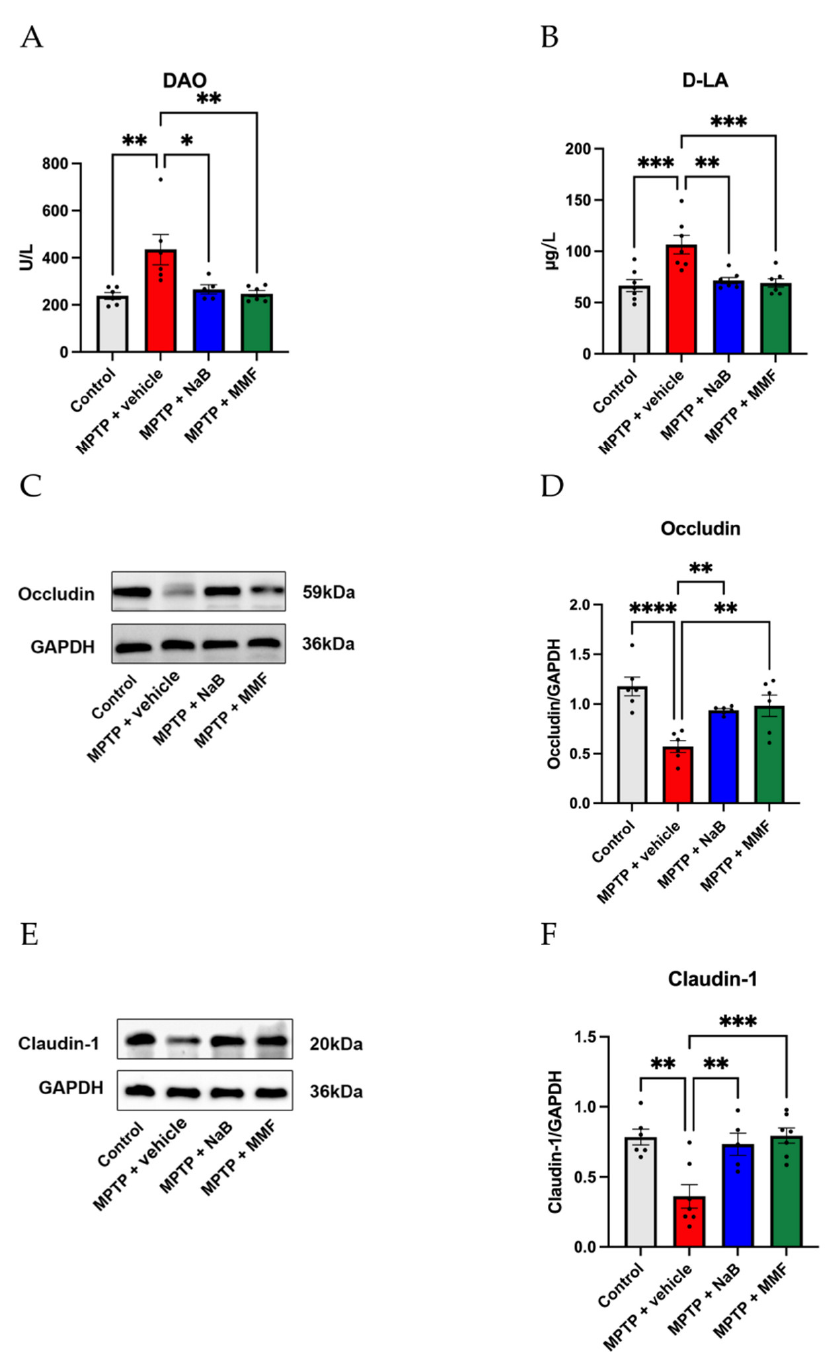
Figure 6. Effects of NaB and MMF on the integrity and permeability of intestinal barrier. ( A ) The content of DAO in each group was detected by ELISA kits. (n = 5–6). ( B ) The content of D-LA in each group detected by ELISA kits. (n = 7). ( C ) Representative immunoblot for Occludin. ( E ) Representative immunoblot for Claudin-1. Alteration of the colon’s intestinal tight junction. Treatment with NaB and MMF increased the expression of the tight junction proteins ( D ) Occludin and ( F ) Claudin-1, which is measured by Western blotting. (n = 5–6). Data are presented as mean ± SEM. * p < 0.05, ** p < 0.01, *** p < 0.001, **** p < 0.0001 versus the MPTP + vehicle group.